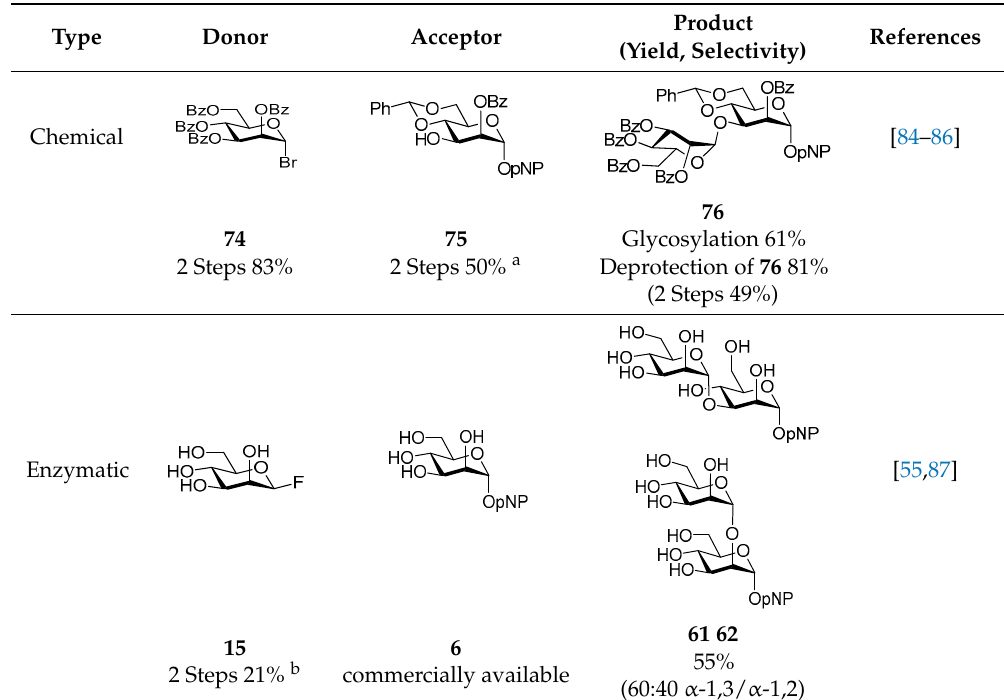
Table 3. Comparison of the required steps and yields of the chemical and enzymatic synthesis of the